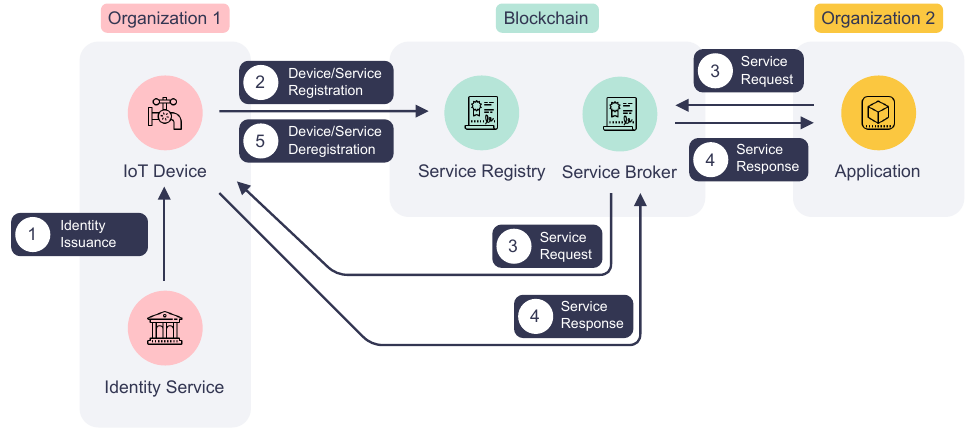
Figure 2. The life cycle of an IoT device and its